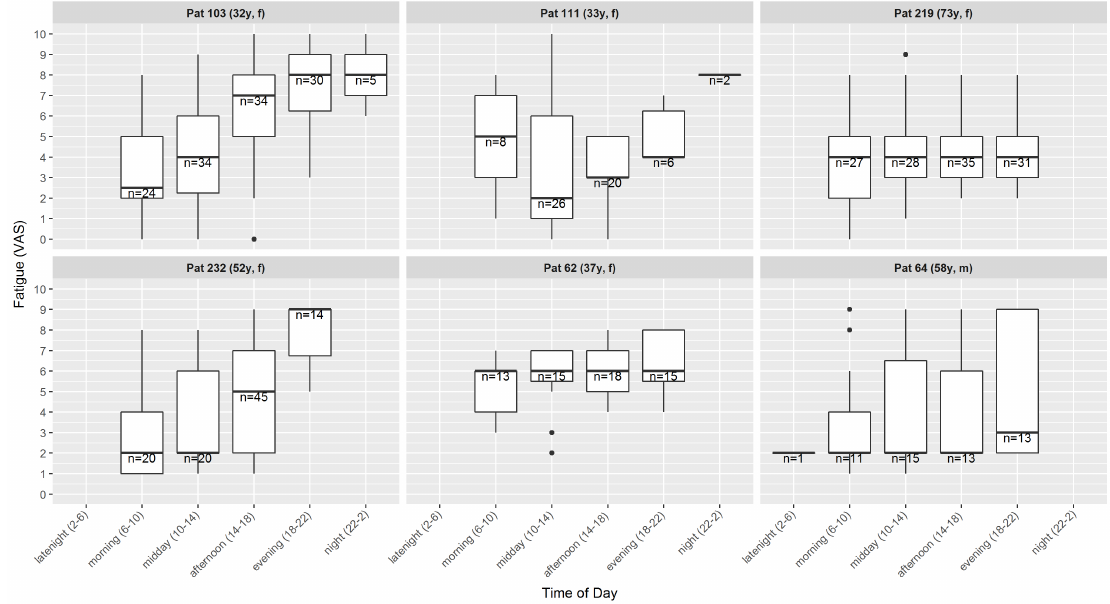
Figure 9. The box plot of perceived fatigue values per time at day shows intra-day variance. The sample size is denoted in each box with n . The bold line in each box denotes the median, the box denotes the IQR and the whiskers extend to the smallest value, highest value resp., within 1.5 × IQR . Points denote outliers, i.e., values that lie outside of the